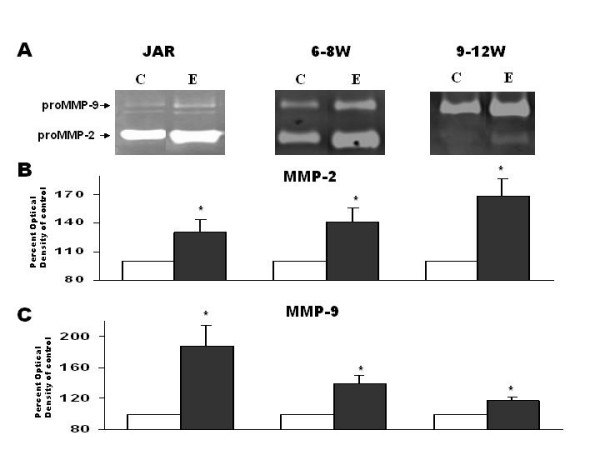
Secretion of proMMP-2 and proMMP-9 after 48 hours incubation of JAR cells, 1st trimester trophoblast cells 6–8 week or 1st trimester trophoblast cells 9–12 week in medium in absence or presence of 8 ng/ml EGF. (A) Representative zymography gels. (B) Bar graph, representing mean ± SEM from 10 independent experiments detecting proMMP-2 (72 kD). (C) Bar graph, representing mean ± SEM from 10 independent experiments detecting proMMP-9 (92 kD). White bars represent control medium of cells without treatment, black bars represent medium from cells with EGF treatment. *P < 0.05 vs. control.